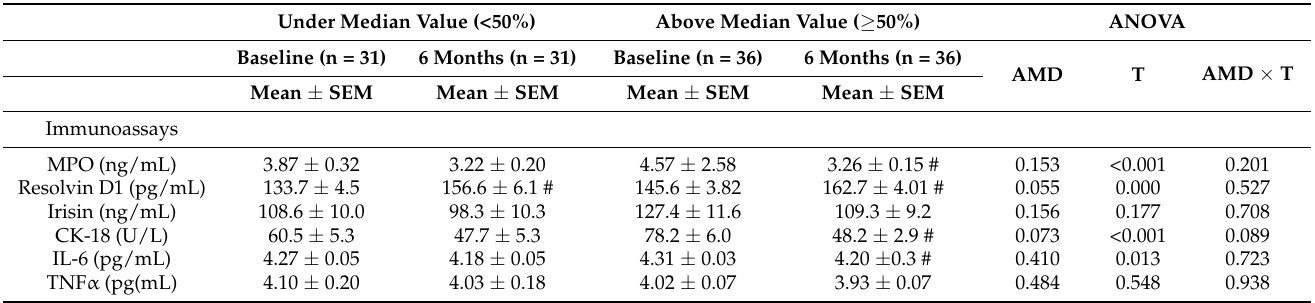
Table 7. Immunoassays in plasma of participants “Baseline” and “6-month intervention” stratified by adherence to Mediterranean diet